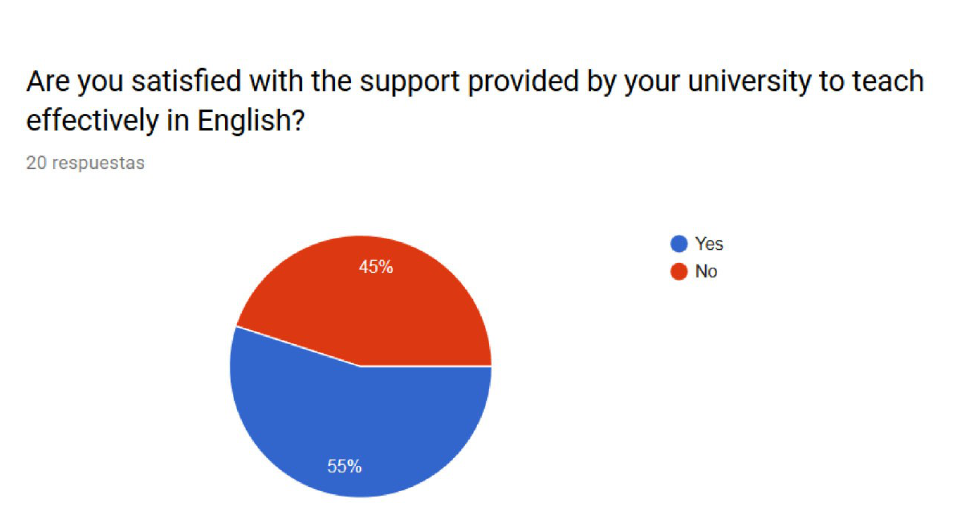
Figure 5. Opinion about support provided by